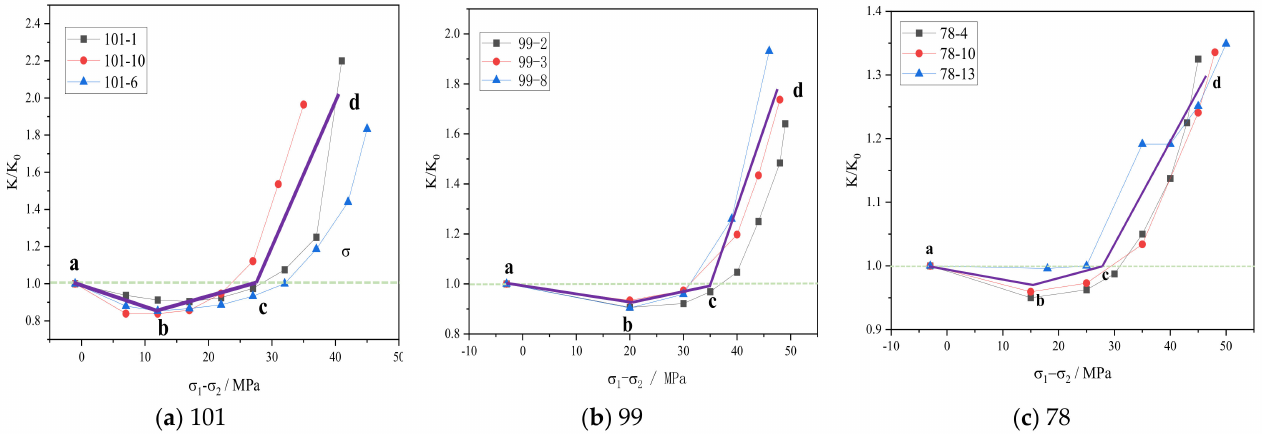
Figure 9. Plots of the relative permeability changing with the stress difference (the 101-core series has a fixed confining pressure of 3 MPa, while the 99-core and 78-core series have a fixed confining pressure of 5